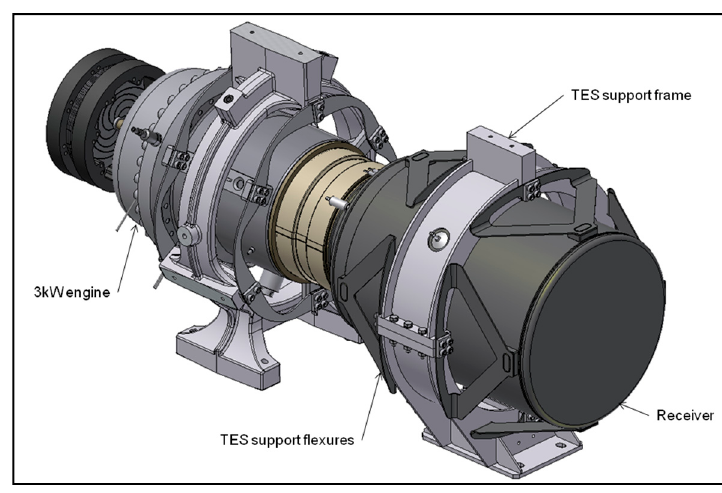
Figure 2. Stirling engine and TES module assembly.